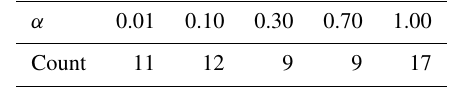
Table 4. Count of unique α in 7-parameter HadAM3